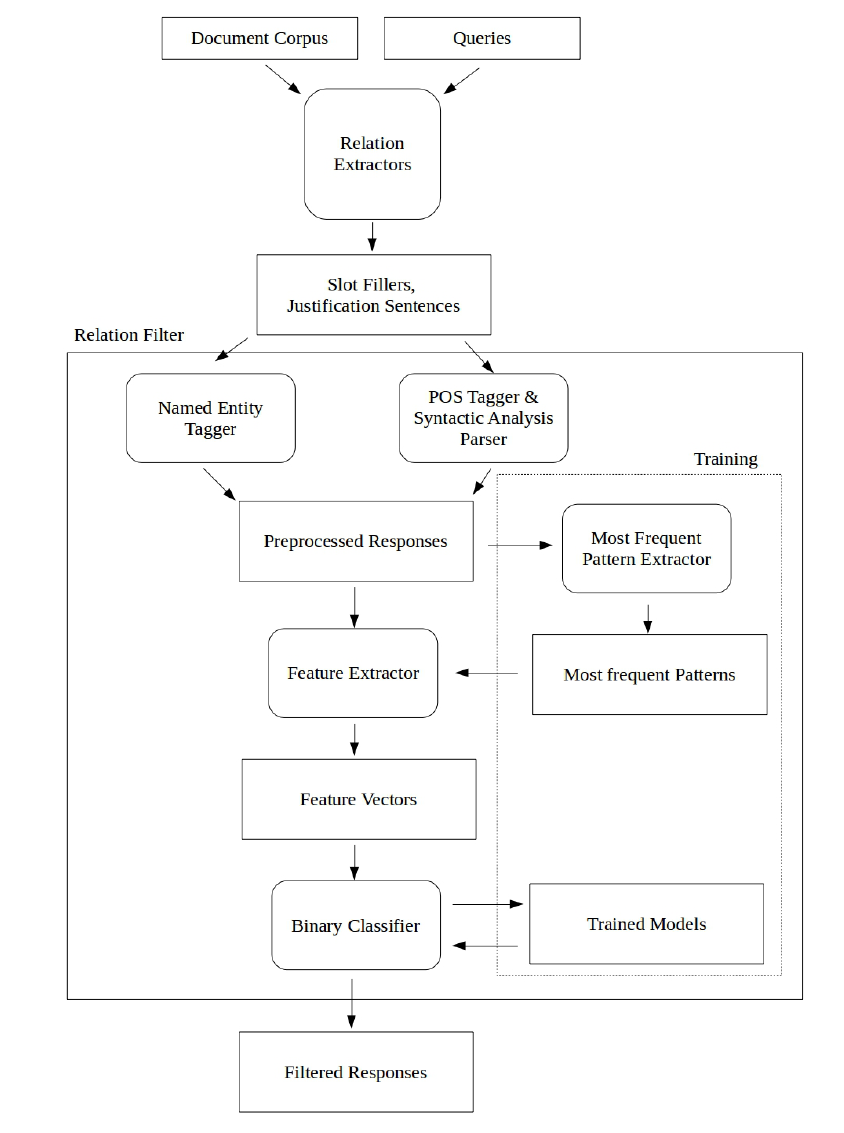
Figure 1. Pipeline describing our